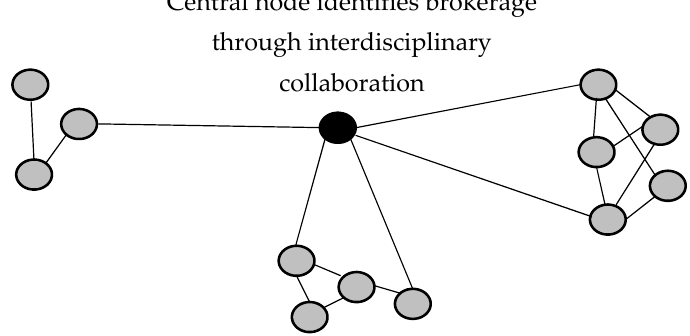
Central node identifies brokerage through interdisciplinary collaboration